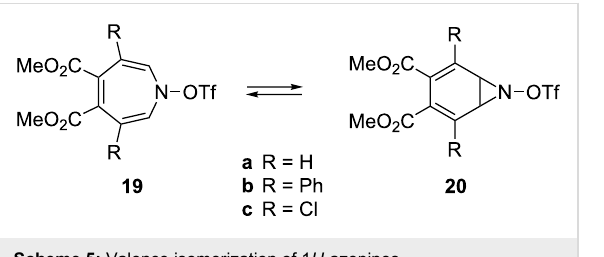
Scheme 5: Valence isomerization of 1 H -azepines.